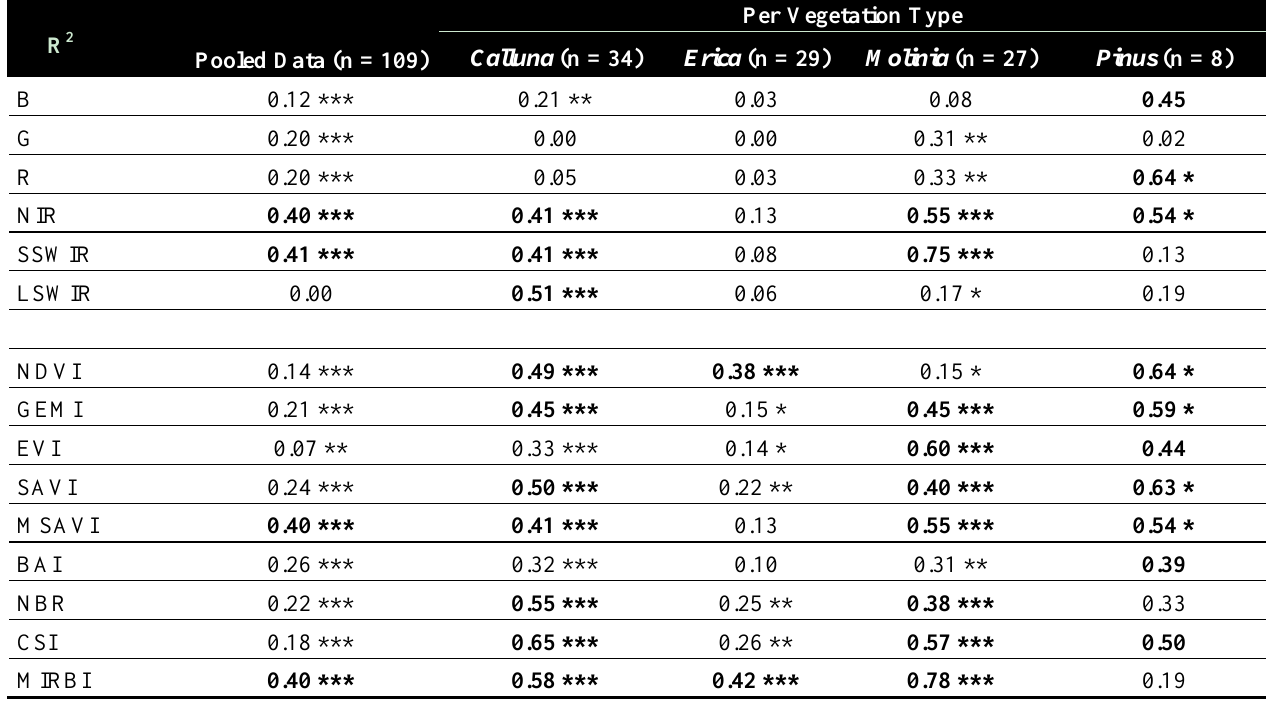
Table 6. Relationship (expressed as R 2 ) between the GeoCBI field data and spectral bands and spectral indices (Table 2) with pooled data and data per vegetation type. R 2